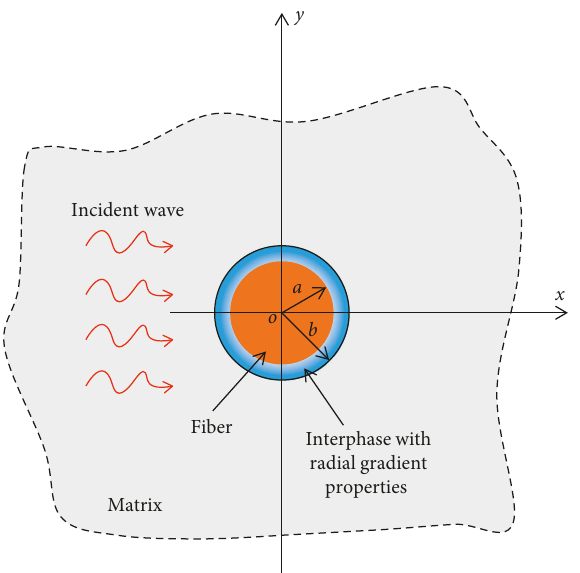
Figure 1: Schematic diagram of a single scattering problem with a radially gradient interphase